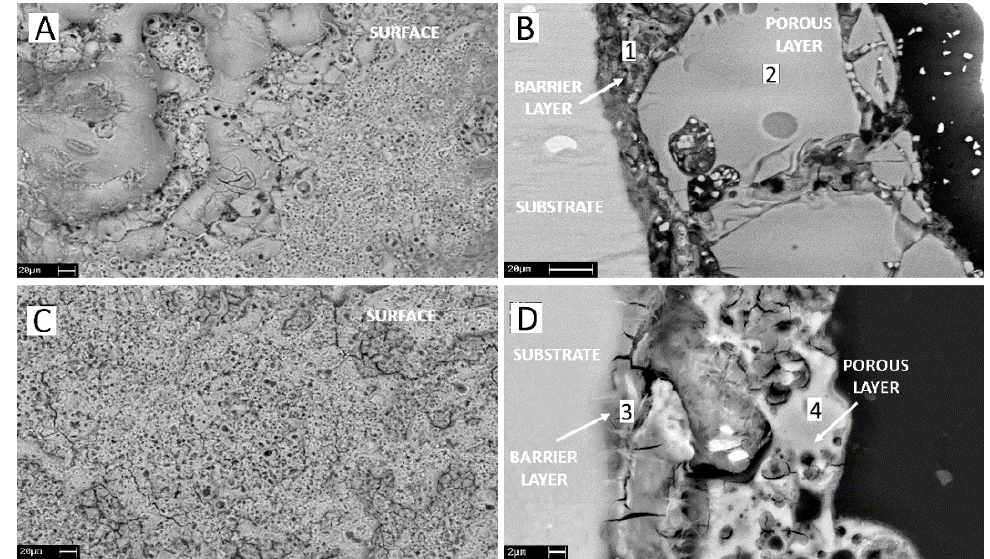
Figure 3. SEM-BSE images of the surface of the sample PEO-Si ( A ) and PEO-P ( C ), and of the cross-sections of the sample PEO-Si ( B ) and PEO-P ( D ).